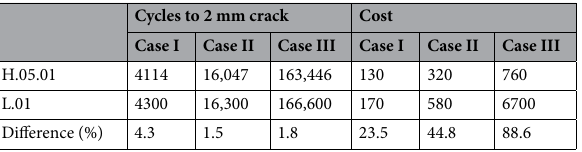
Table 3. Comparison between long, short and reference time-mapping